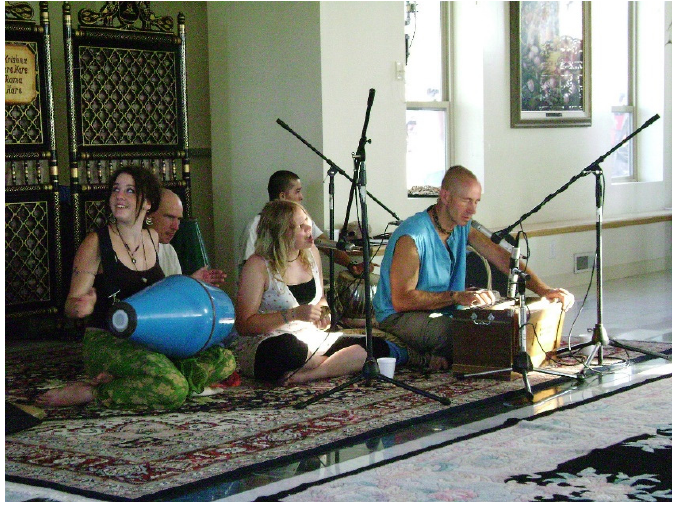
Figure 4. Devotees playing Harmonium, Mridanga and Karatala.